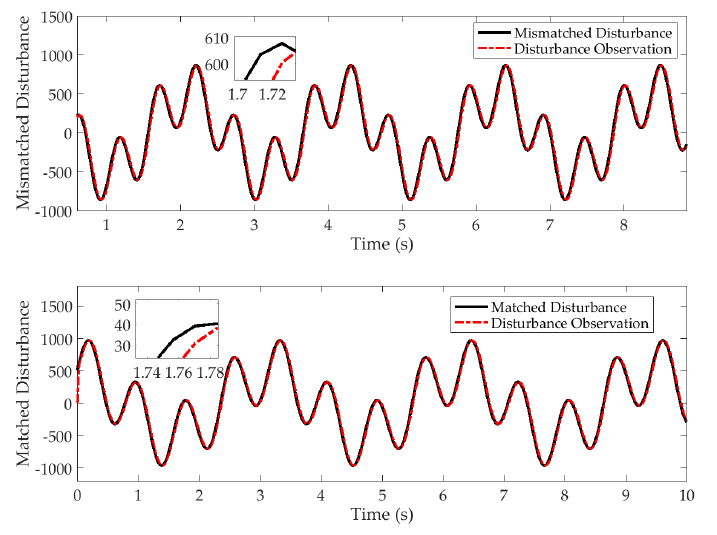
Figure 14. Time response of the 2 ESOs in the controller.